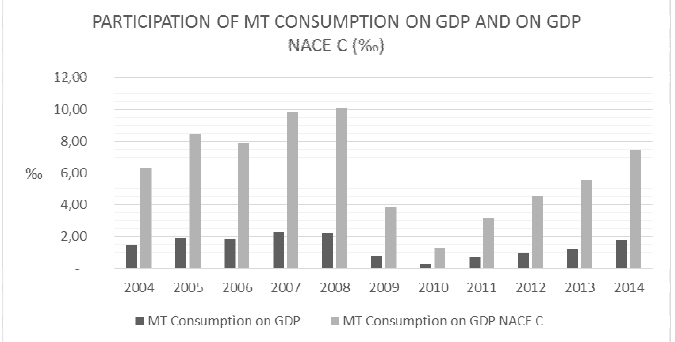
Fig. 9 - Share of consumption of machine tools in creation of the country’s GDP and GDP NACE C in the Czech Republic from 2004 to 2014, constant prices. Source: CZSO, (2017) . Association of Engineering Technology: Reports on the state of Machine Tools Branch in the Czech Republic 2007 –